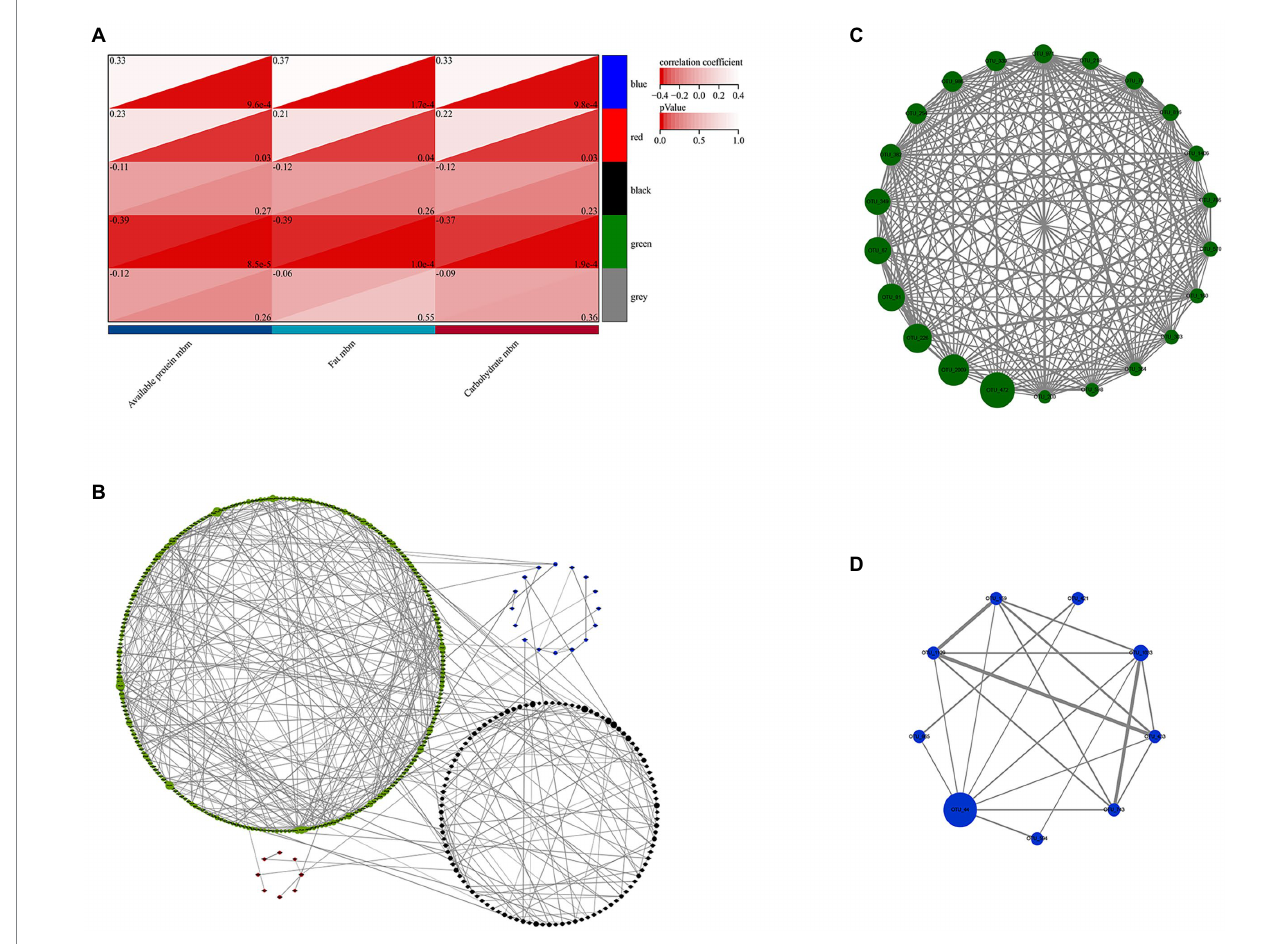
FIGURE 7 Identification of key module and hub OTUs based on WGCNA. (A) Correlation between module eigenvalues and traits of golden snub-nosed monkey. Depth of color corresponds to depth of correlation and p value of each module. (B) Network graph of the hub OTUs. Each node represented the OTUs whose betweenness centrality value was in the top 10%, and its color represented the corresponding module, the size of each node represented the betweenness centrality value, the size of each line thickness represented the weight value between nodes (OTUs). (C) Visualization of full weighted networks of 22 candidate hub OTUs in green module associated with three different nutrients (fat, protein, and carbohydrate). (D) Visualization of full weighted networks of 9 candidate hub OTUs in blue module associated with